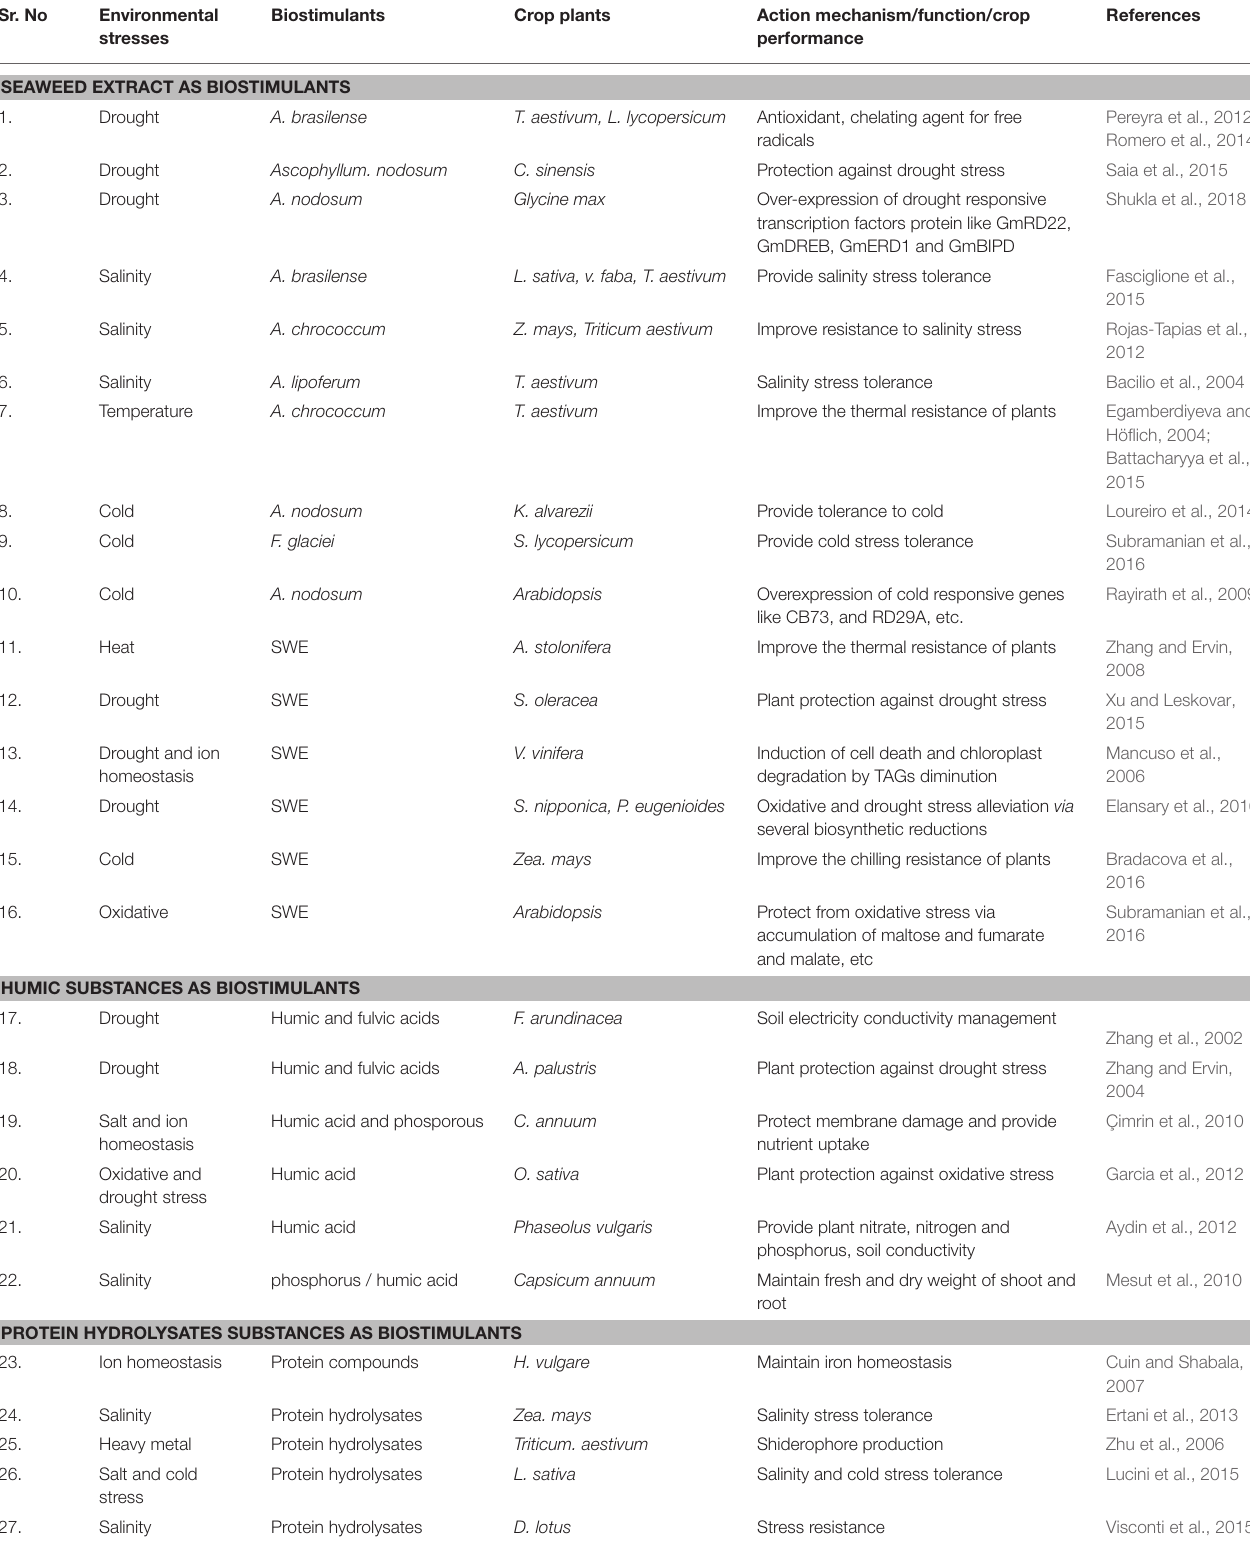
TABLE 1 | The functional and mechanistic roles of several type of biostimulants in crops performances under different abiotic stress condition. Sr.